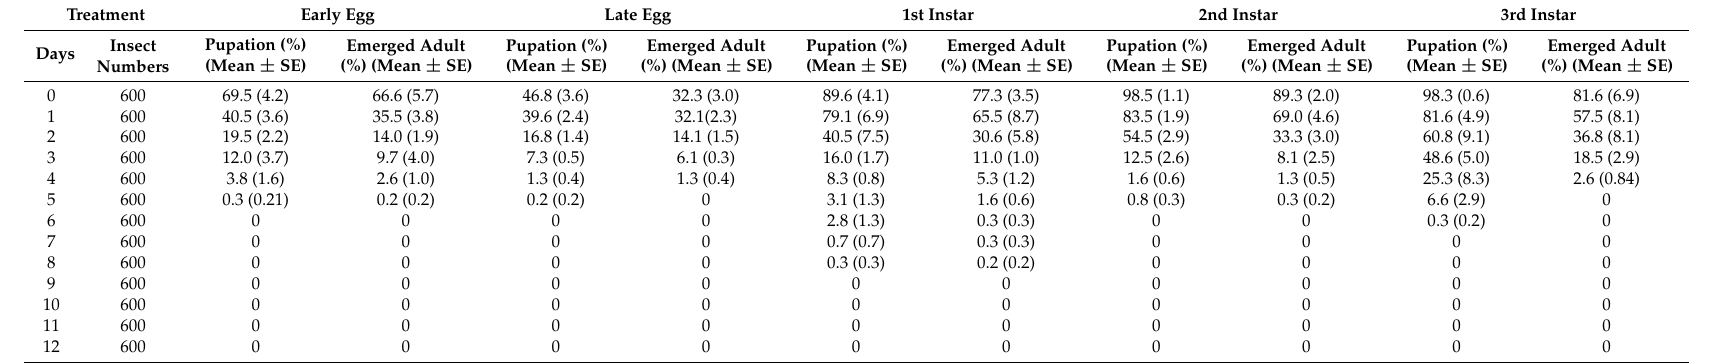
Table 1. Pupation and emerged adult ratios of early eggs (< 6 h), late eggs (>42 h), 1st instar, 2nd instar and 3rd instar larvae of C. capitata fed on lab diet